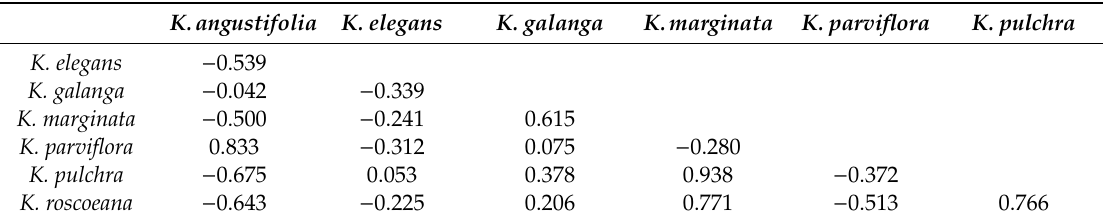
Table 5. Proximity matrix (Pearson correlation coe ffi cient) of the seven Kaempferia species based on the chemical classes